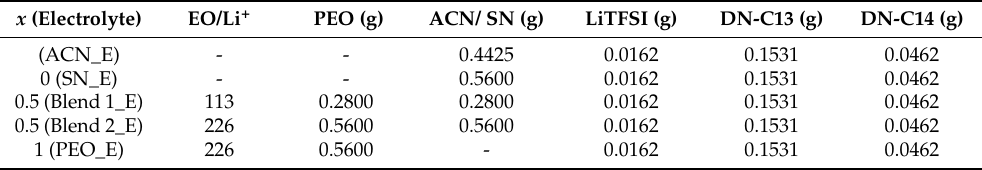
Table 1. Composition of liquid and solid redox mediators.